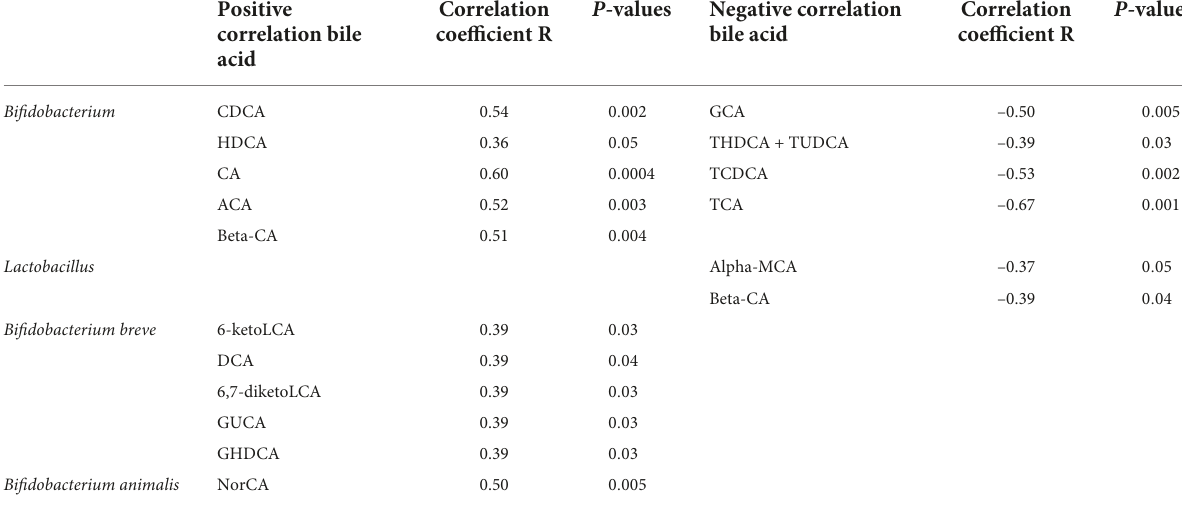
TABLE 2 Correlation between bile acid and